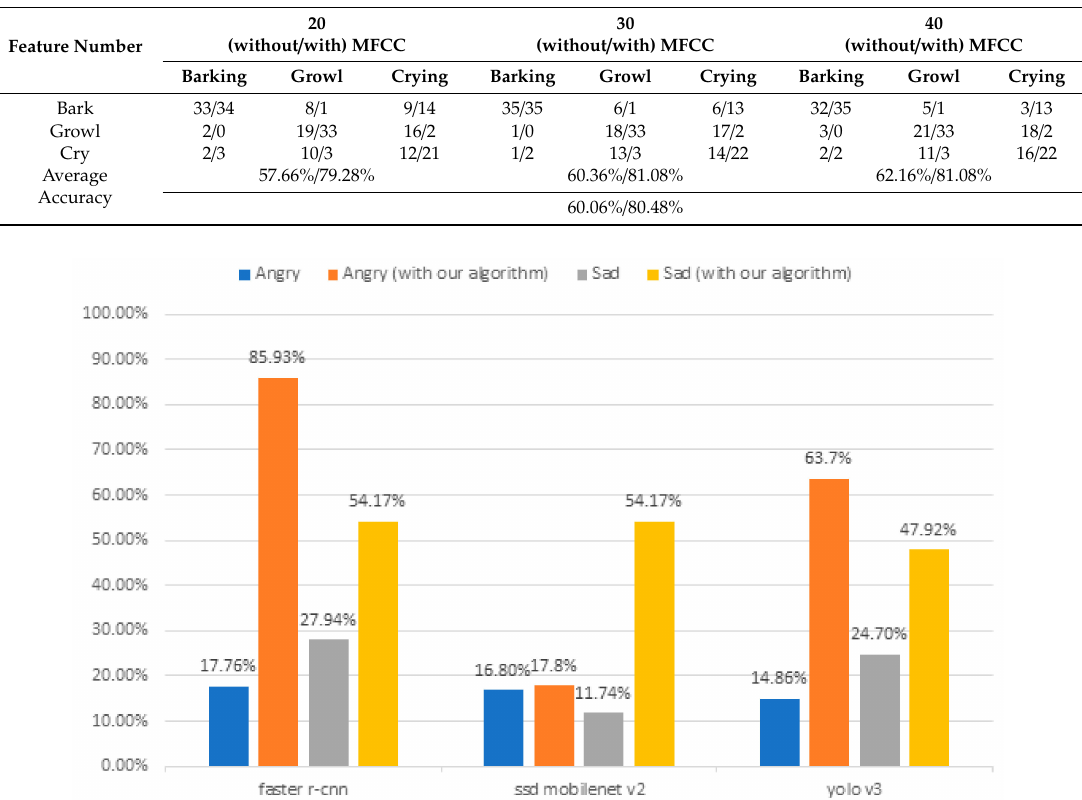
Figure 12. Identification of the accuracy for determining angry and sad